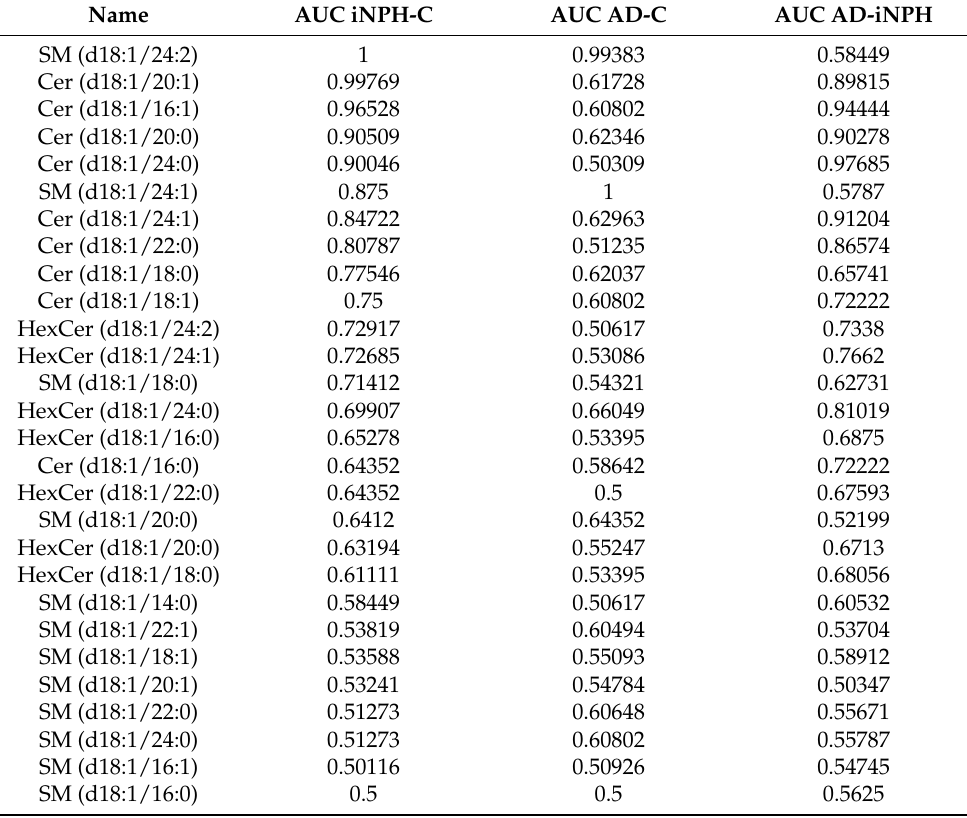
Figure 3. Box plots of ( A ) SM C24:1 and ( B ) SM C24:2 levels in CSF from iNPH and AD patients compared to C subjects. Each measurement was run in triplicate. Data were analyzed using